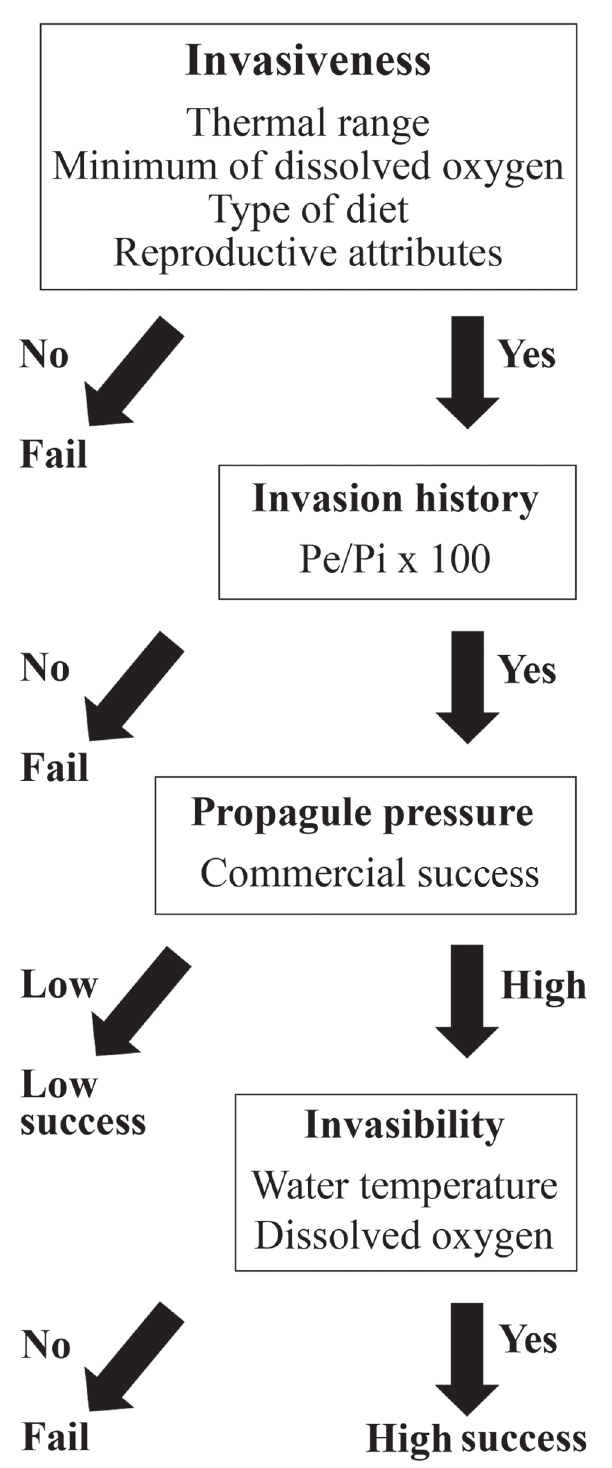
Fig. 2. A model describing the invasion stages that species must pass in order to represent an invasion risk for rivers in Minas Gerais State,